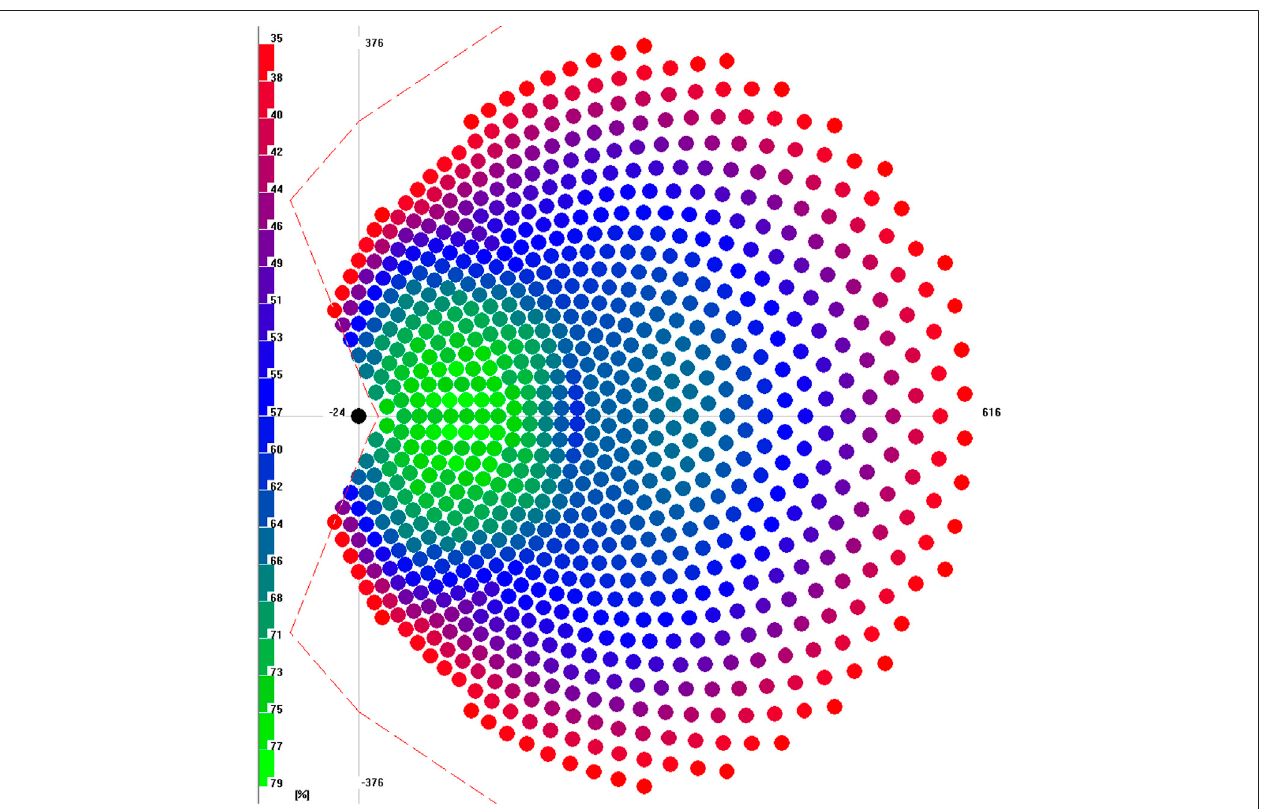
FIGURE 2 | Field con fi guration of a solar tower